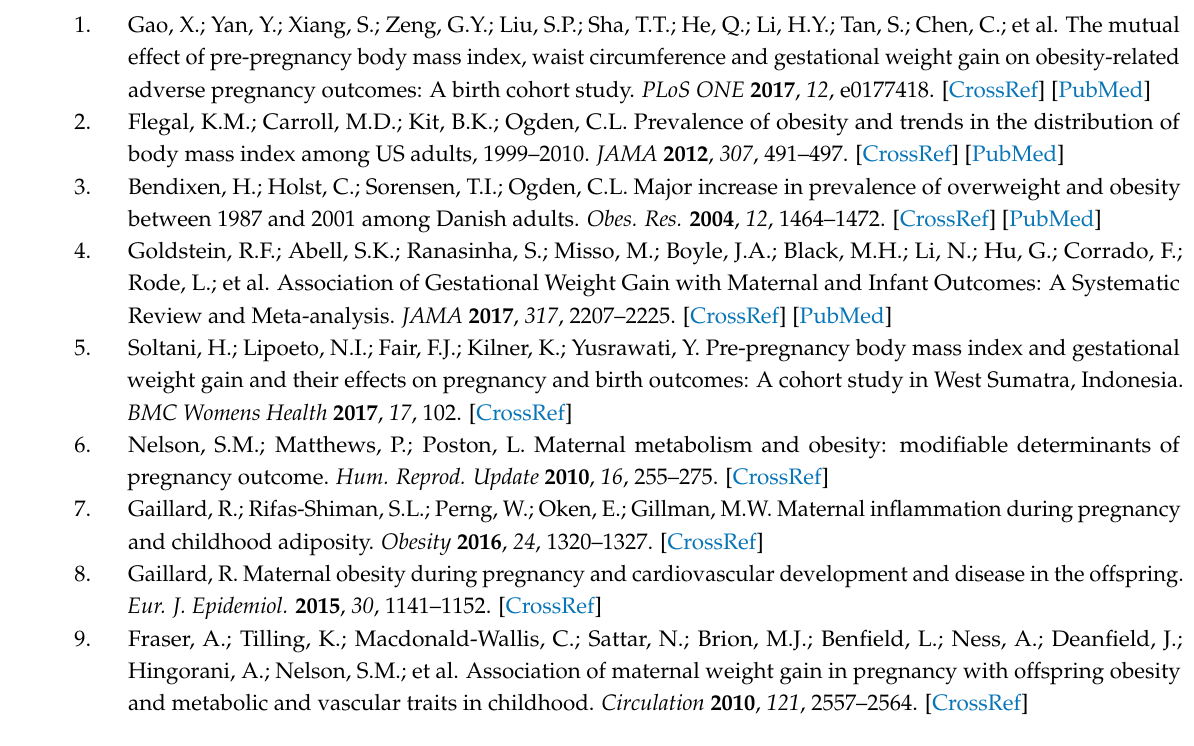
Table S1: Non-response analysis for missing data group and non-missing group, Table S2: Correlation coefficients between maternal pre-pregnancy BMI, GWG, and child weight from birth to 18 months